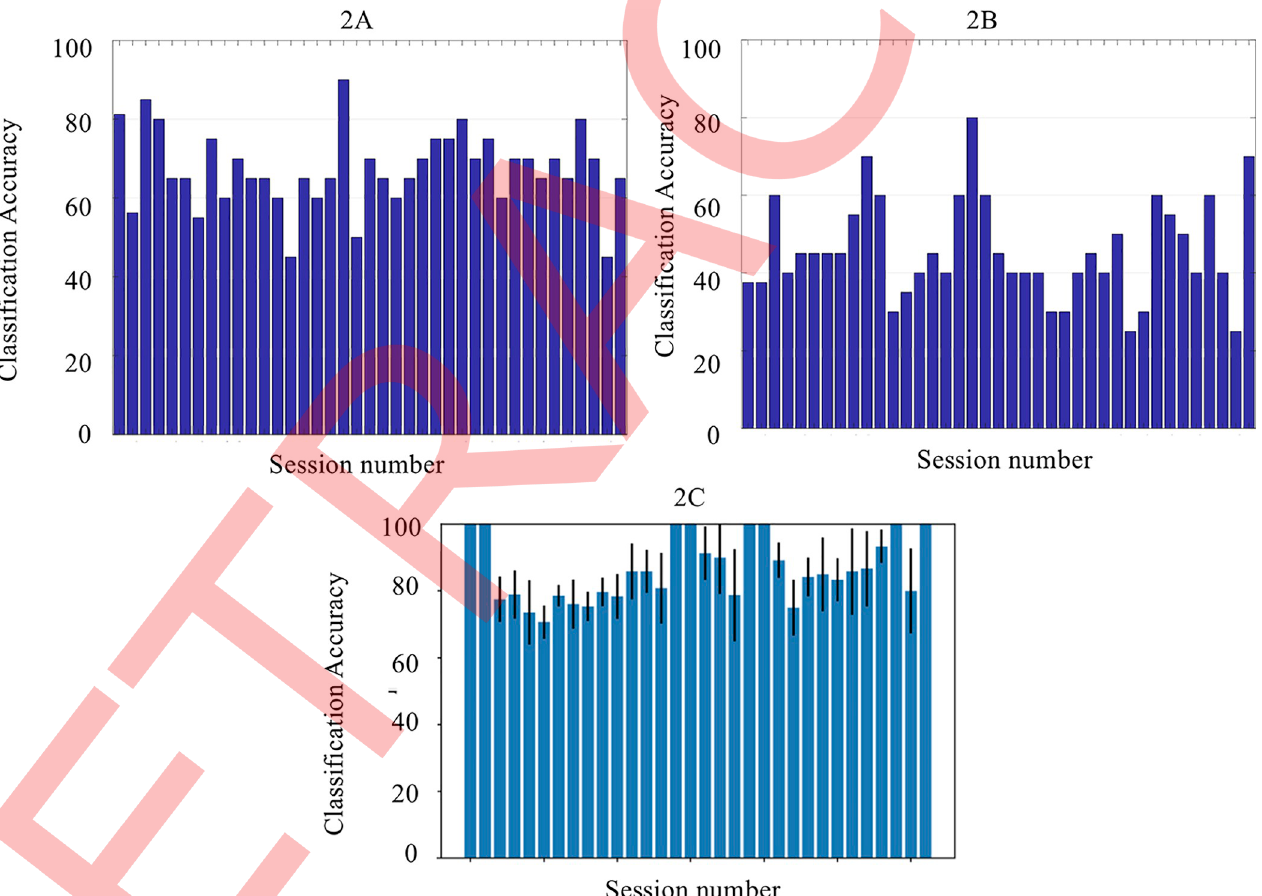
Fig 1. Bar graph of offline classification accuracy results obtained from the sessions performed by the patient B and published by Chaudhary and colleagues [6]. (A) The offline classification accuracy of sessions performed by patient B using the method reported by Chaudhary and colleagues, i.e., the mean O 2 Hb response was used as input feature for the linear support vector machine classifier. (B) The offline classification accuracy of sessions performed by patient B using the method suggested by Martin Spu¨ler. (C) The offline classification accuracy of sessions performed by patient B using the CSP for feature extraction and using linear SVM classifier. CSP, common spatial pattern; O 2 Hb, oxy-hemoglobin; SVM, support vector machine.